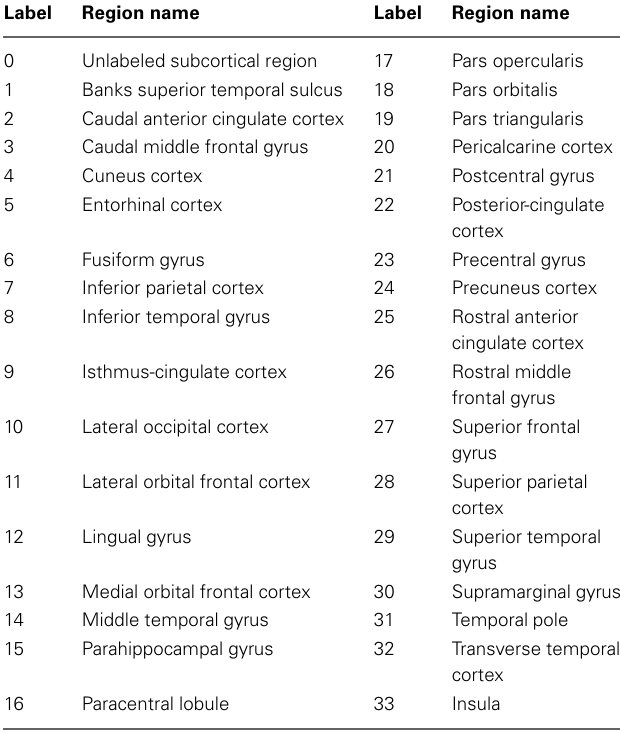
Table 5 | FreeSurfer’s regions.